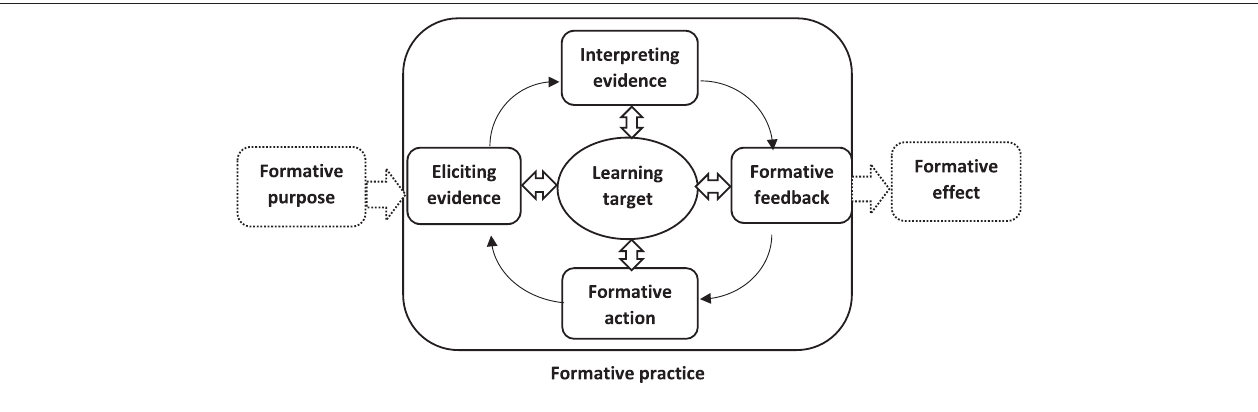
FIGURE 1 | Operationalizing formative